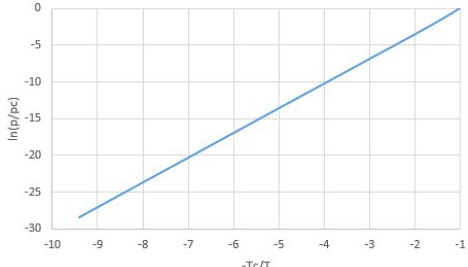
Figure 4. Vapor pressure line for a van der Waals fluid. We see that although the latent heat ∆ h vanishes towards the critical temperature, the relation between the logarithm of vapor pressure and inverse temperature is nearly a straight line up to the critical temperature. This is possible because the molar volume and entropy differences Δ v and Δ s also vanish towards the critical temperature.